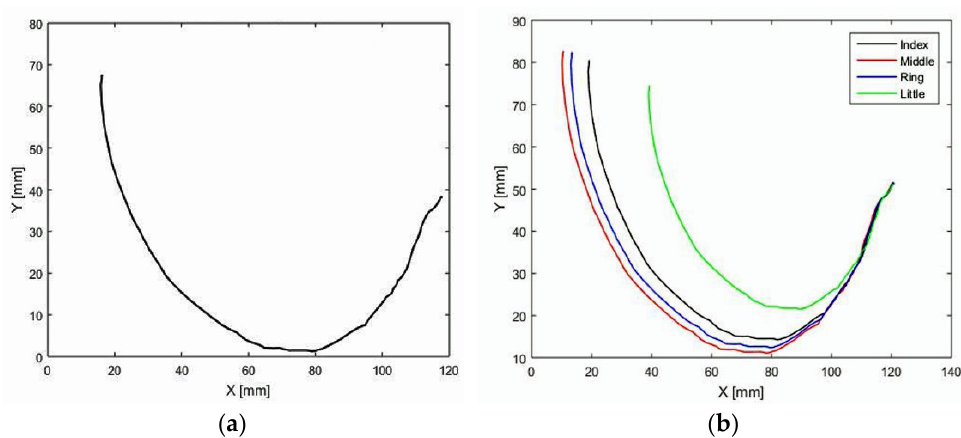
Figure 3. Trajectories of the fingers: ( a ) 𝑥 vs 𝑦 trajectory of Q point (index fingertip); and ( b ) trajectories of the fingers Index, middle, ring, and little.